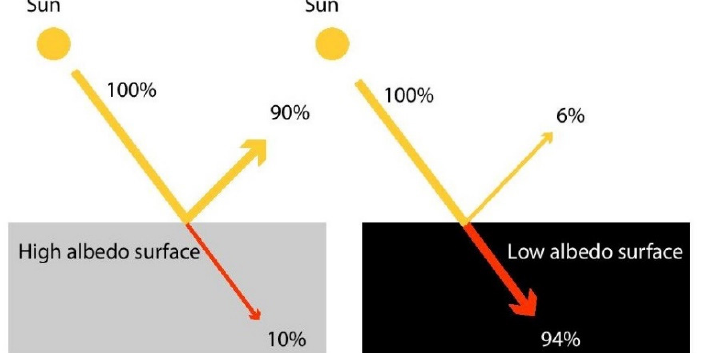
Figure 3. Albedo effect: the percentages of solar radiation indicated above as being reflected/absorbed are only indicative.